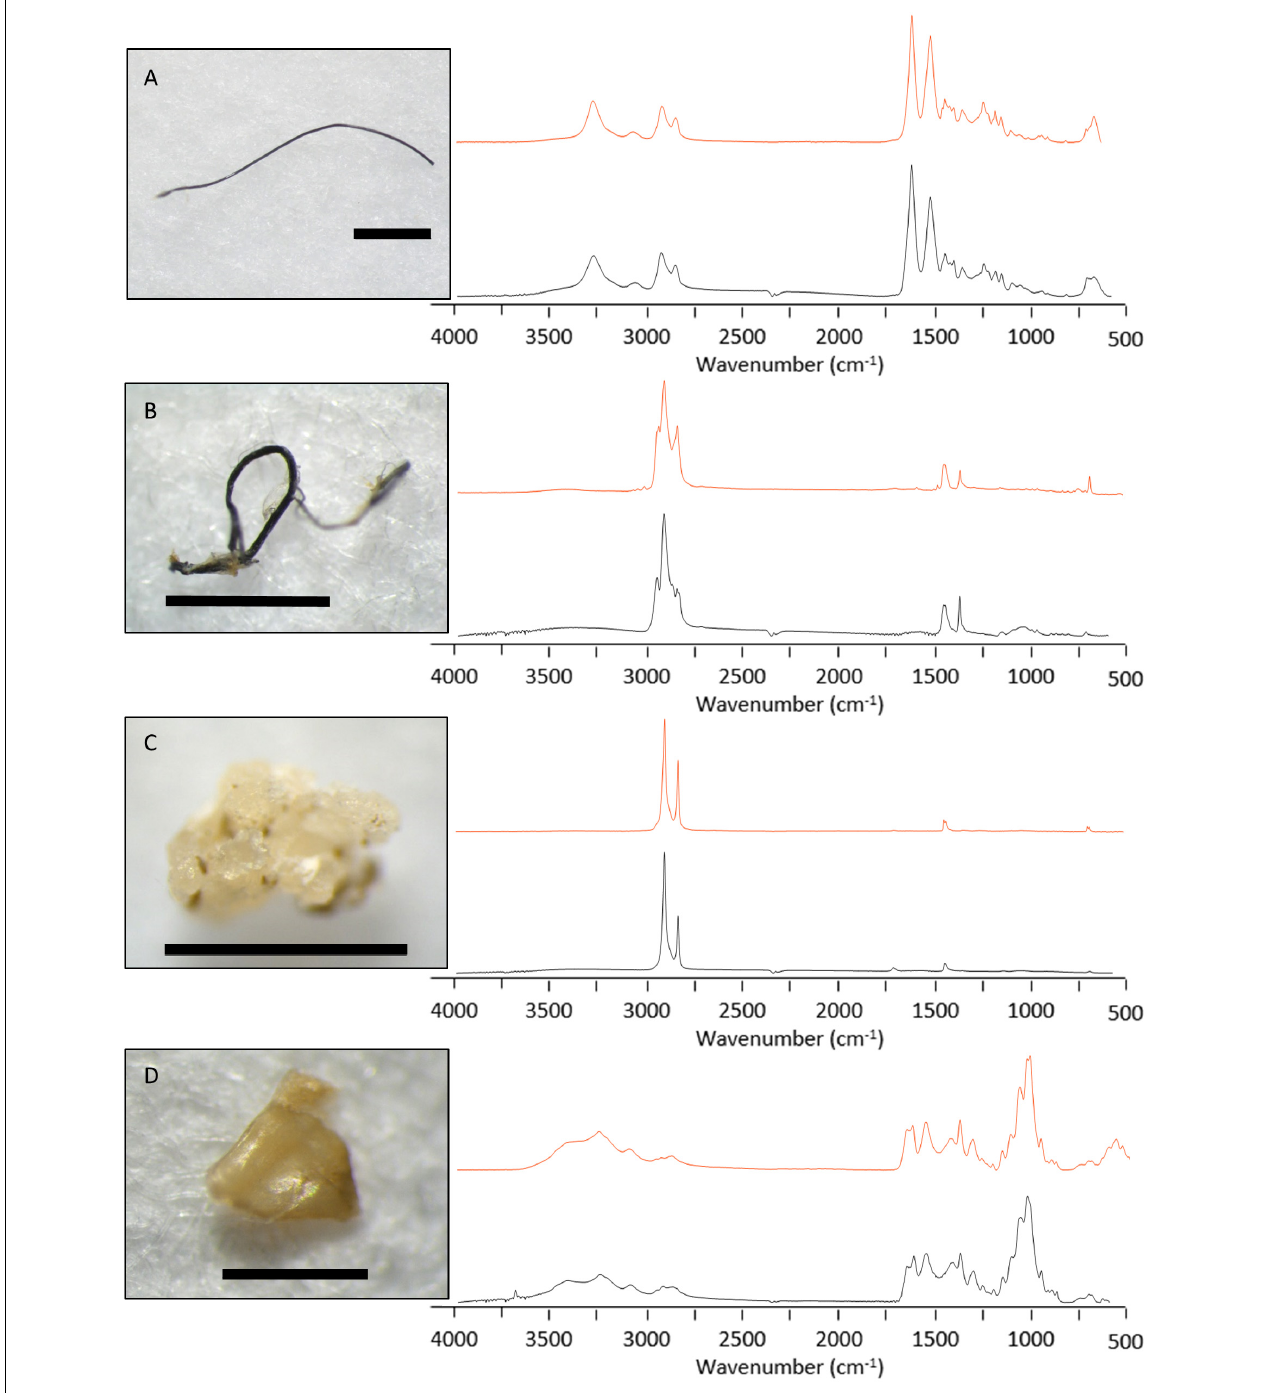
FIGURE 5 | Spectral match information for four particles recovered from the gastrointestinal tract of sardines caught in Frenchman Bay, Western Australia in January 2019. The upper (red) line illustrates Bio-Rad KnowItAll R (cid:13) database reference spectra, with the lower (black) line representing the measured spectra. Spectral analysis identified these particles as (A) nylon, (B) polypropylene, (C) polyethylene, and (D) chitin. Image scale bars represent (A–C) 1 mm and (D) 0.5